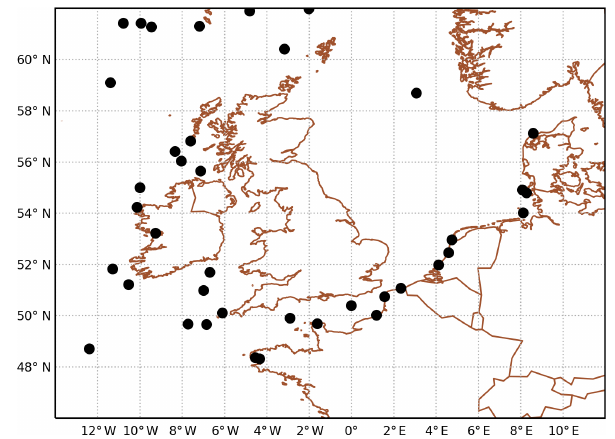
Figure 2. Observation locations within the domain for 12:00UTC on 6 June 2019.